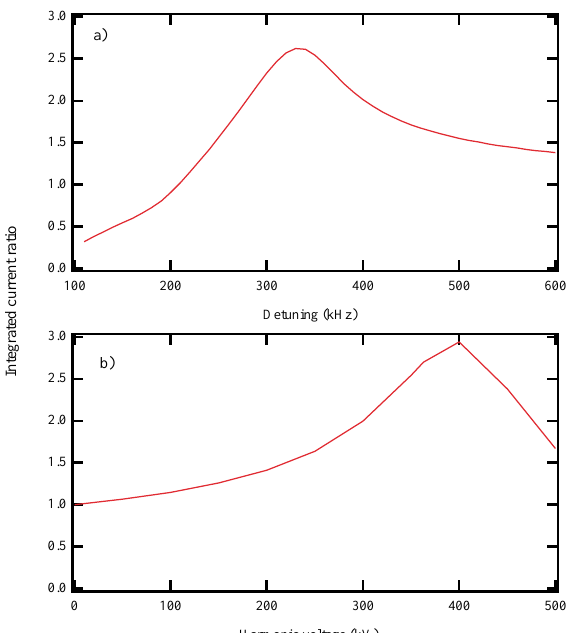
FIG. 6. (Color) Increase in integrated current for (a) fixed detuning of three NC harmonic cavities and (b) fixed voltage of 360 kV.